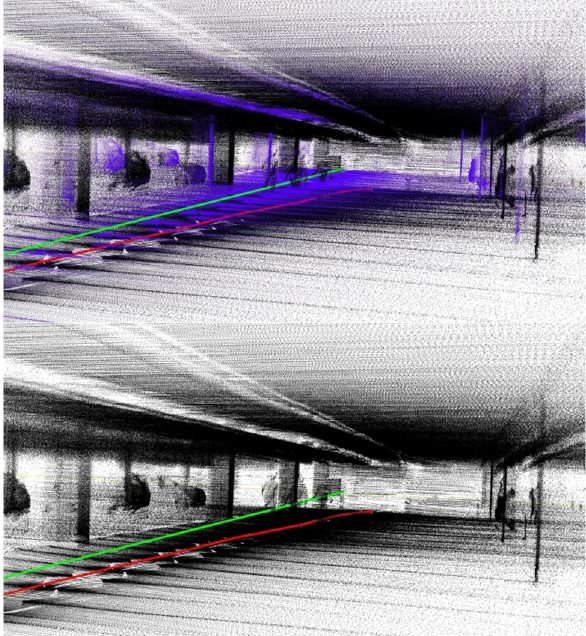
Figure 4. Top: Close-up view on concrete pillars without outlier filtering and a (green) straight trajectory (shown in violet). Objects are dislocated, and may assume oblique shapes. With filtering and corrections, objects are properly located inside the point cloud, and recover their natural shapes (shown in black). The point cloud is derived from the (red) corrected trajectory. Bottom: Only the filtered and corrected point cloud is shown. Both trajectories are visible in both images for visualization purposes.